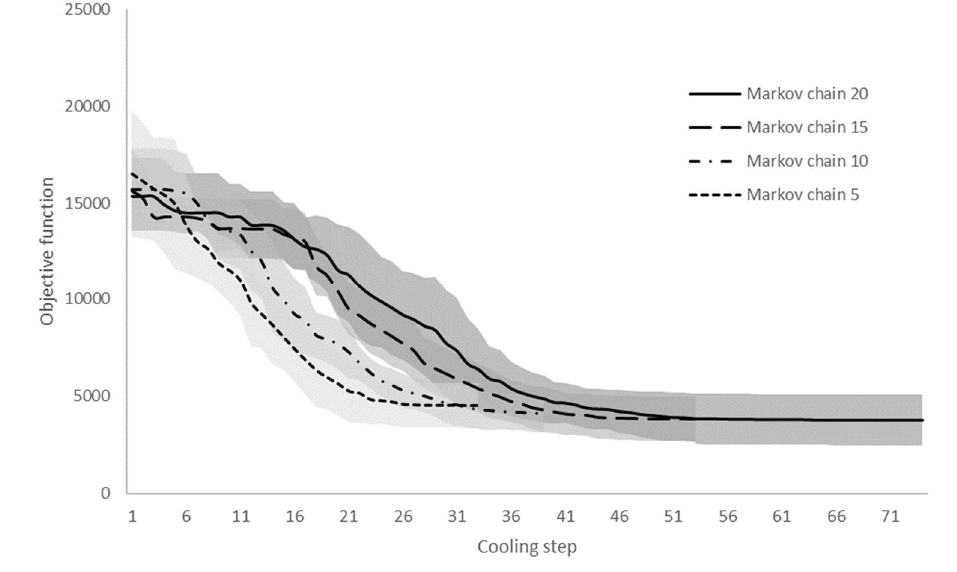
Figure 1. Objective function versus cooling step using 49 parallel